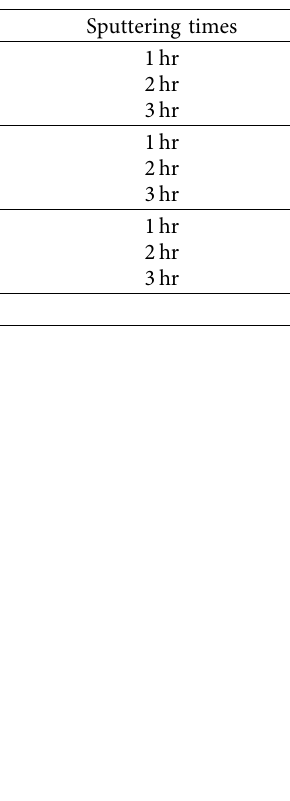
Figure 8: EDS of Nb, Ta, and V nanocoated specimens at diferent sputtering times. Table 5: Surface roughness of coated (Nb, Ta, and V) specimens and untreated 316L SS substrates at 3 diferent sputtering times (1, 2, and 3hours).